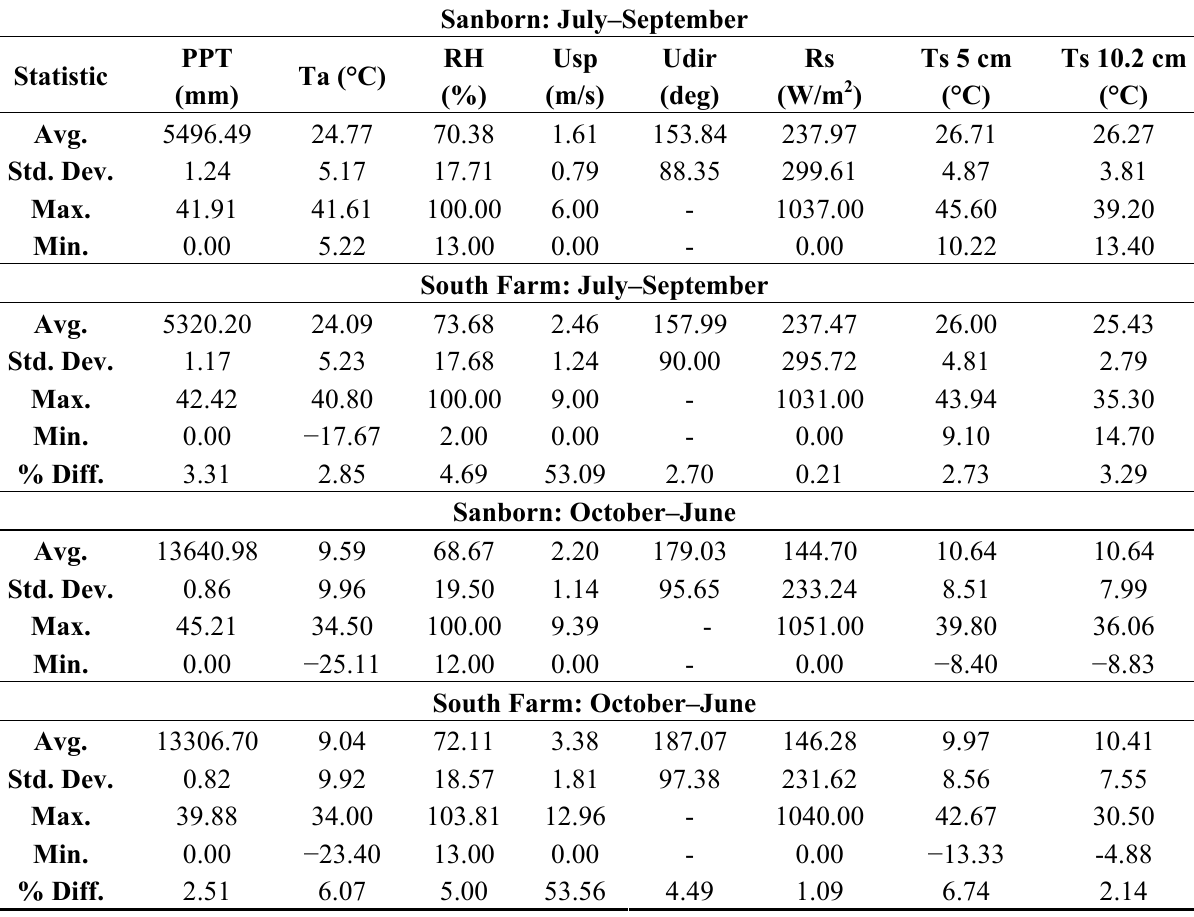
Table 4. Climate descriptive statistics recorded at Sanborn and South Farm monitoring sites during summer months (July–September) relative to fall through spring months PPT = precipitation, Ta = air temperature, RH = relative humidity, Usp = wind speed, Udir = wind direction, Rs = shortwave radiation, Ts = soil temperature.